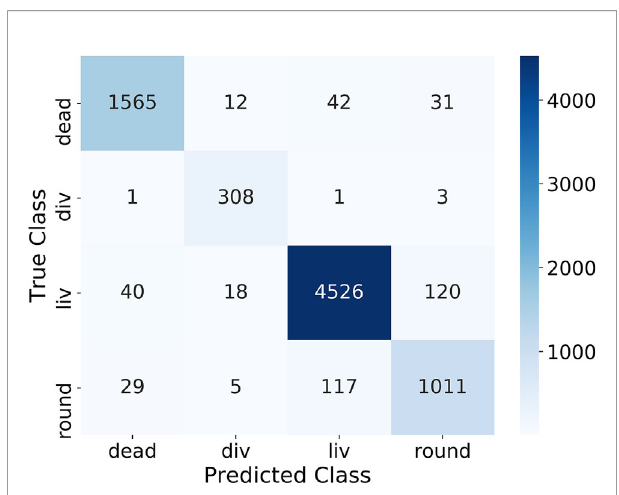
FIGURE 2 | The confusion matrix of the classi fi cation of the dataset on a simple CNN.